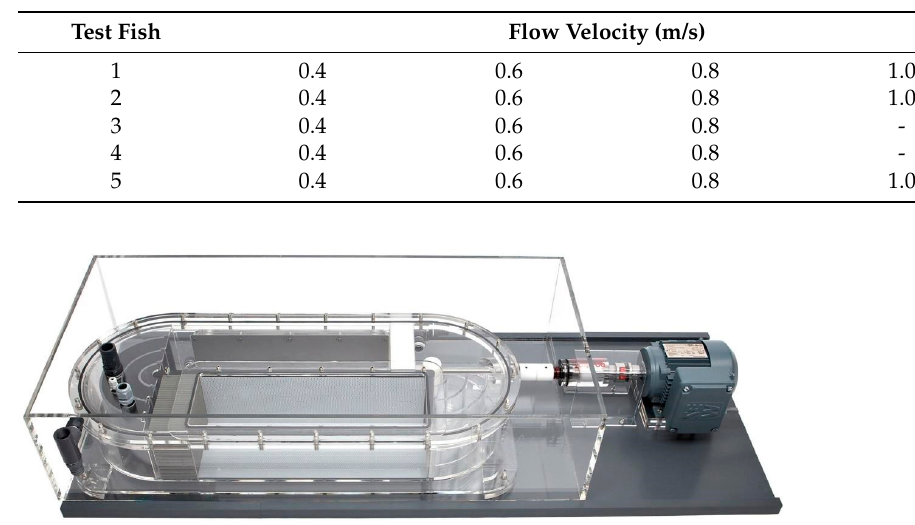
Table 1. Flow velocities for the stepped velocity test.